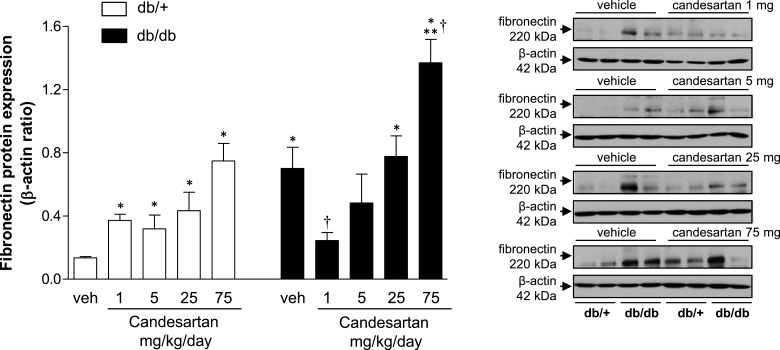
Candesartan modulates expression of pro-fibrotic and pro-inflammatory markers in kidney cortex from db/db miceProtein expression of fibronectin in kidney cortex from db/+ and db/db mice treated with vehicle or candesartan (1, 5, 25 or 75 mg/kg/d). Side panels, representative immunoblots of fibronectin and β-actin. Results are presented as mean ± S.E.M. of 5–7 mice. *P<0.05 compared with vehicle-treated db/+; **P<0.05 db/db compared with db/+ of corresponding candesartan dose; †P<0.05 candesartan-treated db/db compared with vehicle-treated db/db.